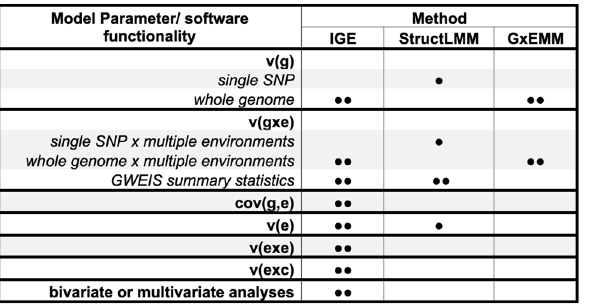
Table 3. Comparisons of methods (software packages) on the genomic and exposomic analysis of complex traits. IGE (proposed method): integrative analysis of genomic and exposomic data. StructLMM & GxEMM are existing linear mixed models that incorporate genetic and exposomic effects on phenotypes. ● : the parameter is included in the model, but the parameter estimate is not provided by the software package. ●● : the parameter is included in the model, and the parameter estimate is provided by the software package. v(g): additive genetic variance due to either a single SNP or all common SNPs (i.e., whole genome). v(gxe): GxE variance due to either interactions of a single SNP or all common SNPs with multiple exposomic variables. GWEIS: Genome-wide by environment interaction study. Using the SNP BLUP method, the software for IGE (mtg2 v2.18) provides allele substitution effects of SNPs across environments, their standard errors and p-values. The StructLMM software provides allele substitution effects and p-values for GxE interactions. cov(g,e): covariance between genomic and exposomic effects on phenotypes. v(e): variance due to additive effects of exposomic variables. v(exe): variance due to exposome x exposome interactions. v(exc): variance due to exposome x covariate (e.g., demographics) interactions. bivariate or multivariate analyses: analyses that simultaneously involve two or more